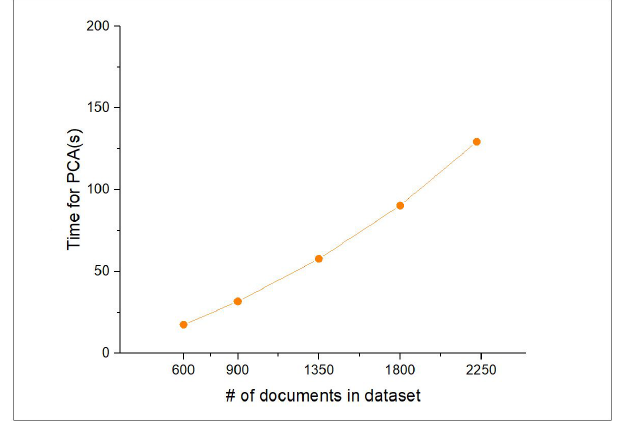
Figure 5. Time of doing PCA.